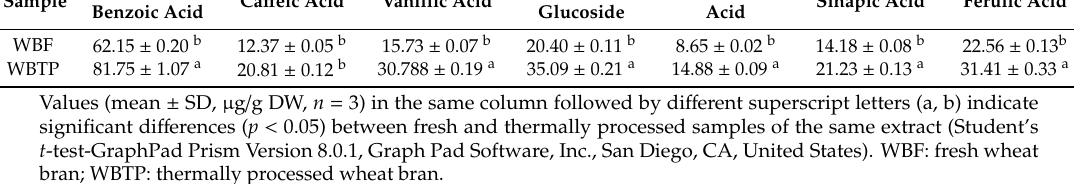
Table 2. Phenolic compound analysis of the fresh and thermally processed wheat bran samples.